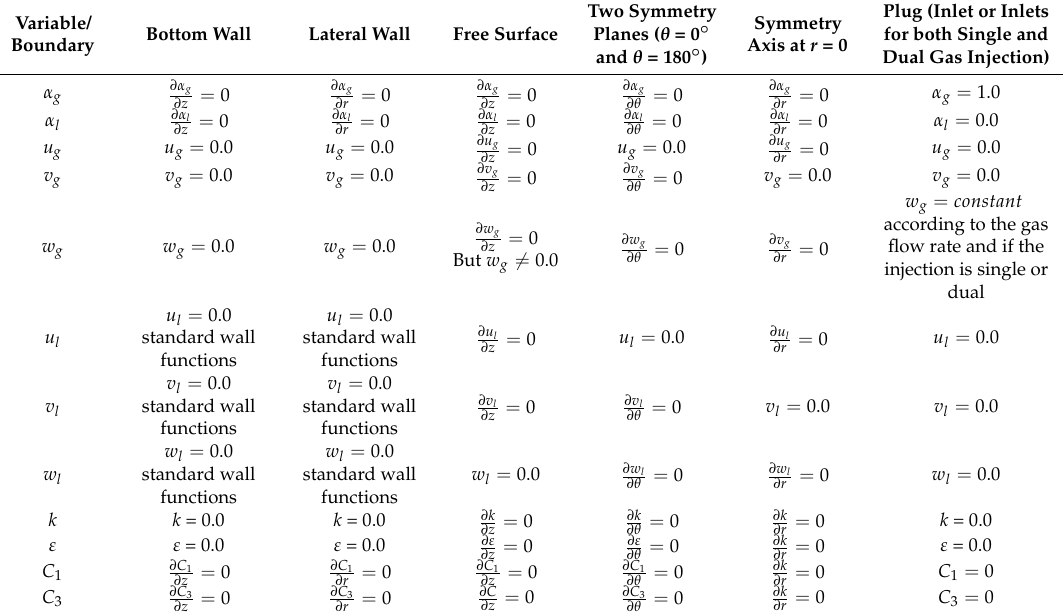
Table 1. Boundary conditions of the mathematical